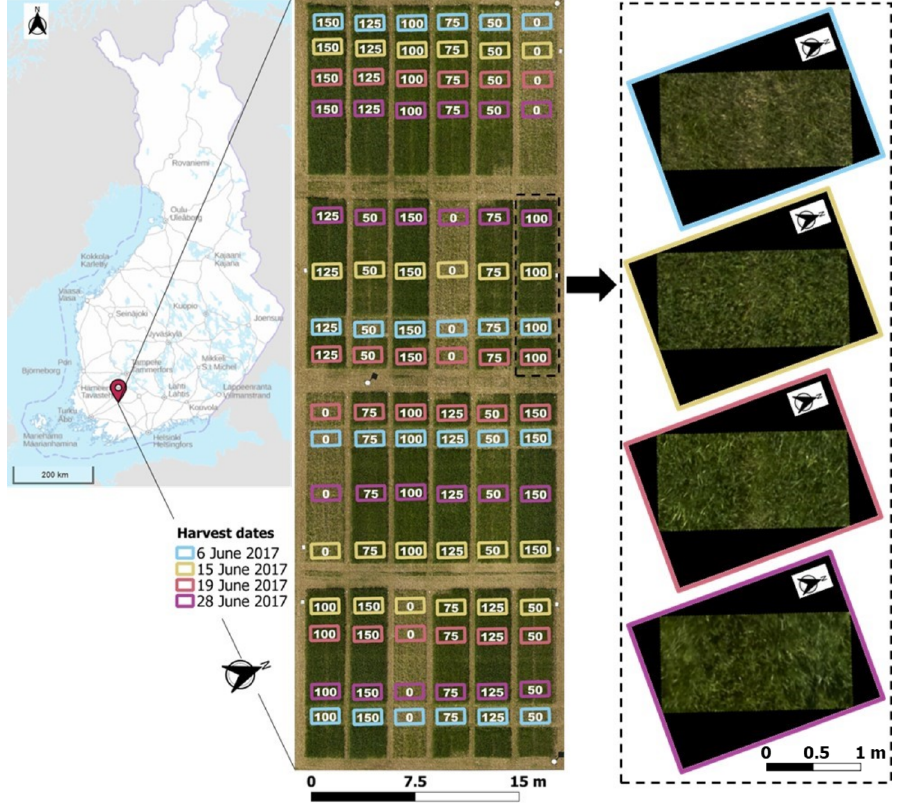
Figure 2. Location of the study area in Jokioinen, Finland. Orthomosaic for 15 June, as well as the location of the harvesting for the reference sample plots and their nitrogen fertilizer rates, from 0 to 150 kg/ha, indicated inside the polygons. On the right side, from top to bottom, examples of image patches extracted from the